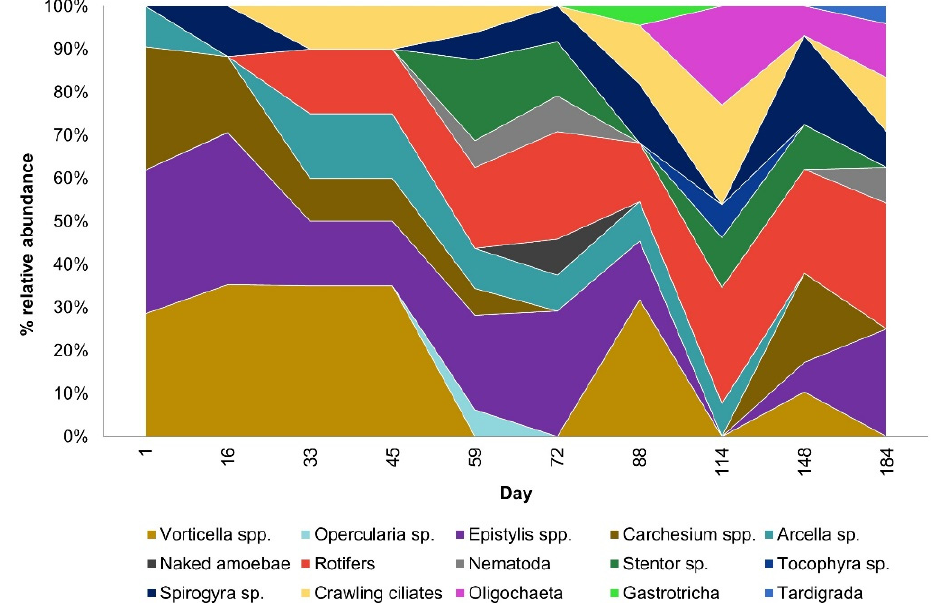
Figure 9. Composition of protozoan and metazoan in activated sludge samples during 184 days of operation.